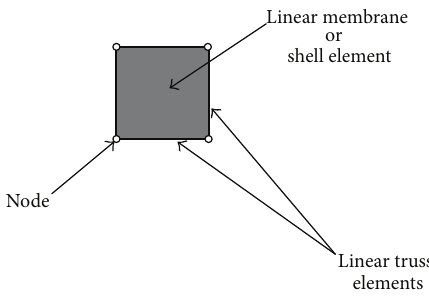
Figure 1: FE unit cell representation of textile structure modelled using mutually constrained membrane and truss elements (from Harrison et al.